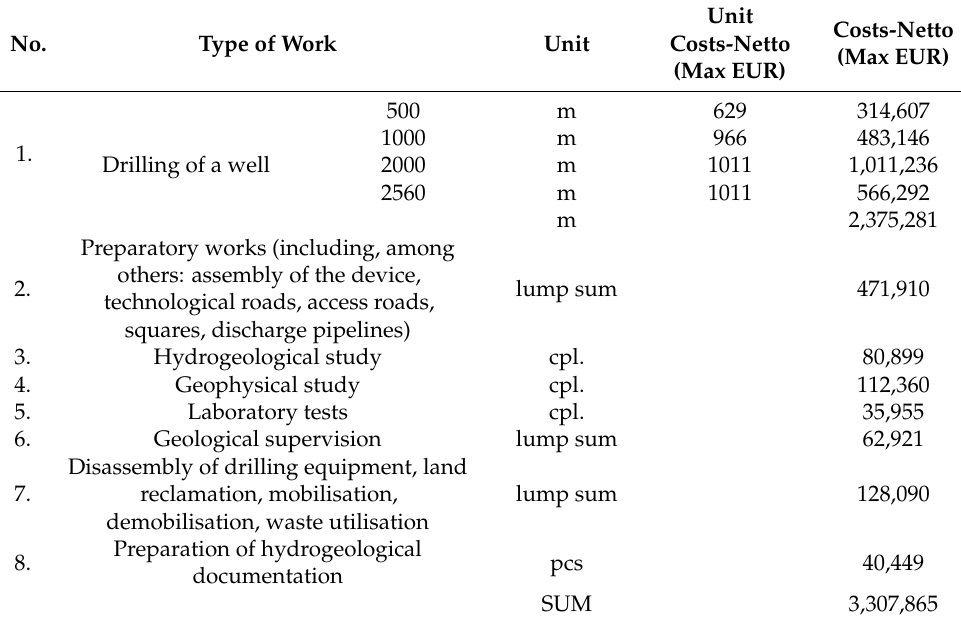
Table 9. Net costs of drilling work for the Gucin location [64].